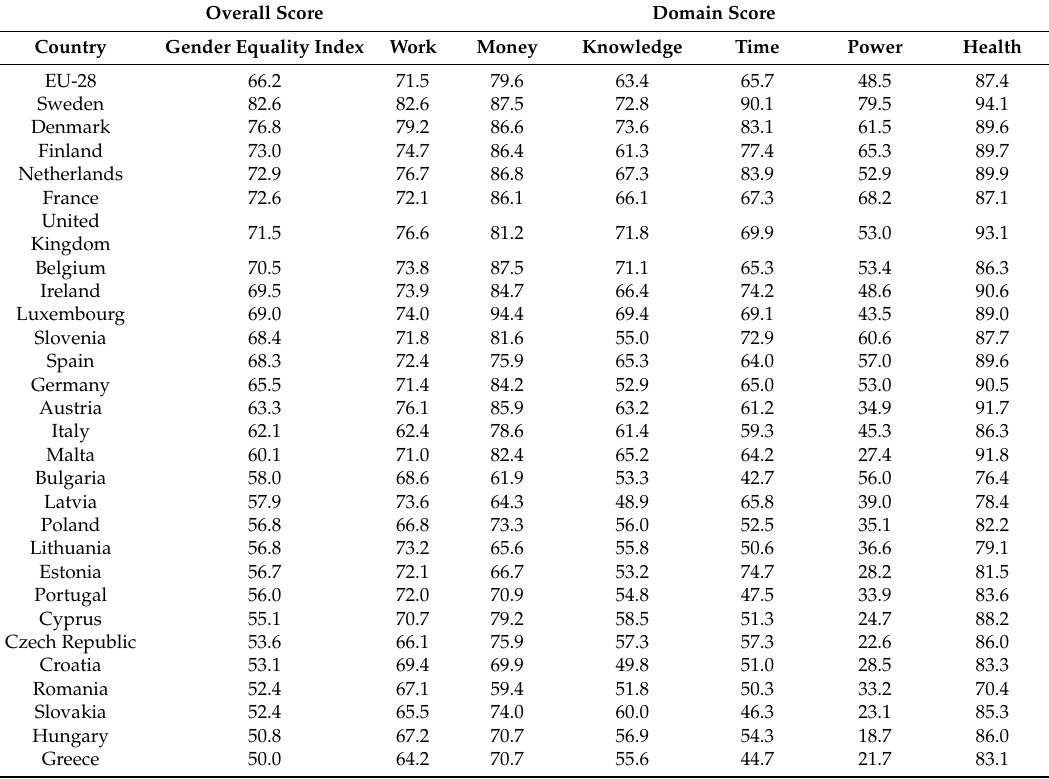
Table 1. EIGE Gender Equality Index 2015 and sub-indexes by country (EIGE 2017a). Overall Score Domain Score Country Gender Equality Index Work Money Knowledge Time Power